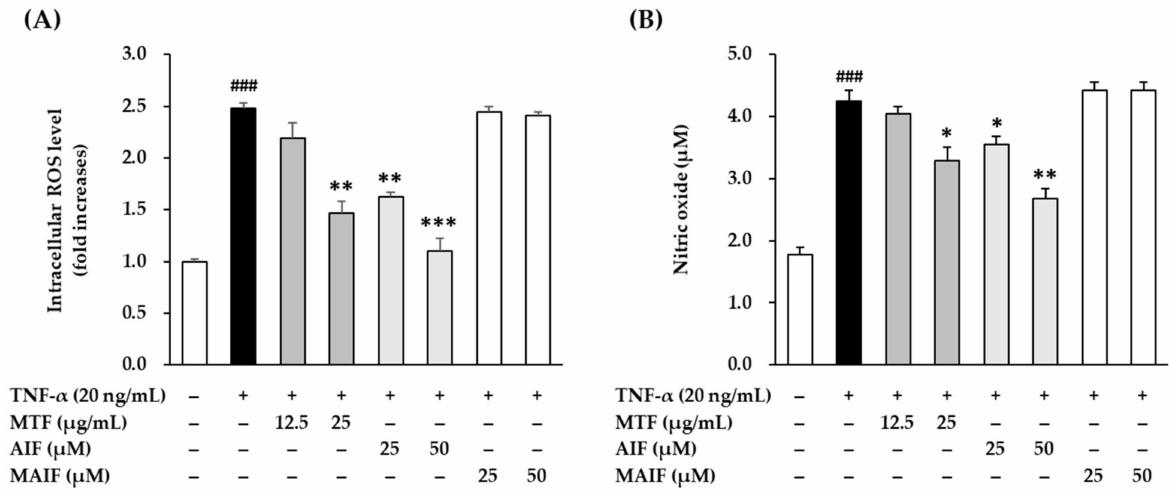
Figure 3. Scavenging of intracellular reactive oxygen species (ROS) ( A ) and pro-inflammatory mediator nitric oxide (NO) ( B ) by M. tricuspidata fruit extract (MTF), alpinumisoflavone (AIF), and 4 (cid:48) - O -methyl alpinumisoflavone (MAIF) in tumor necrosis factor- α (TNF- α )-treated human dermal fibroblasts (HDFs). HDFs were challenged with 20 ng/mL TNF- α in the presence or absence of MTF (12.5 and 25 µ g/mL), AIF (25 and 50 µ M), and MAIF (25 and 50 µ M) for 30 min or 24 h. The levels of ROS and NO were quantified by using 2 (cid:48) , 7 (cid:48) -dichlorofluorescin diacetate (DCFDA) stain and Griess assay. The data are presented as mean ± SEM of at least three independent experiments. ### p < 0.001 as compared with the untreated cells. * p < 0.05, ** p < 0.01 and *** p < 0.01 as compared with the TNF- α -treated